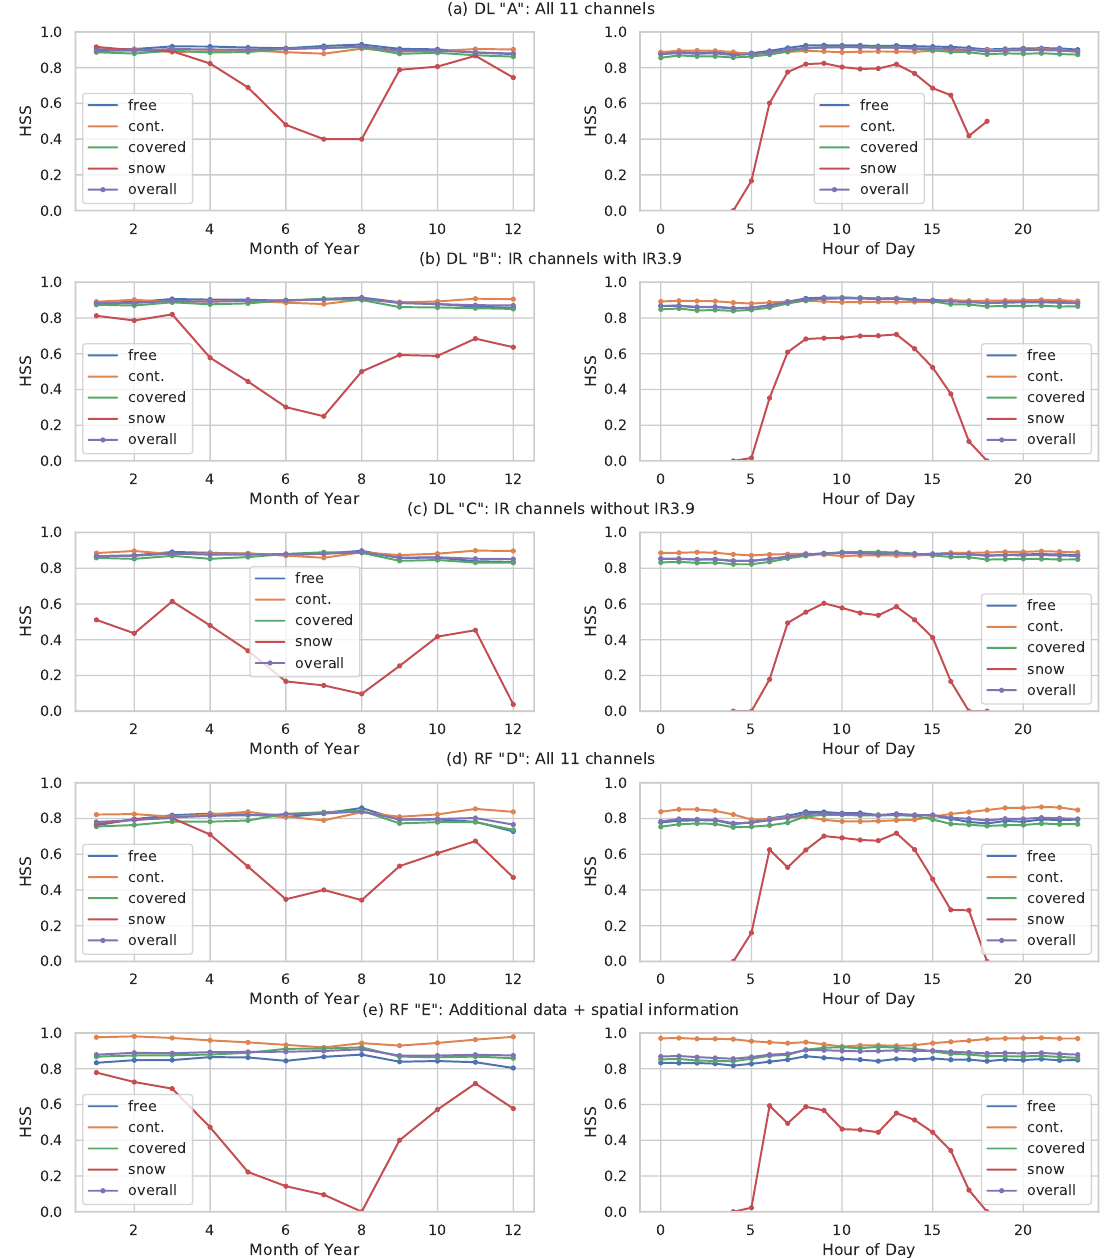
Figure 8. Plots of HSS median values from all results of 7977 test scenes grouped by month of the year and hour of the